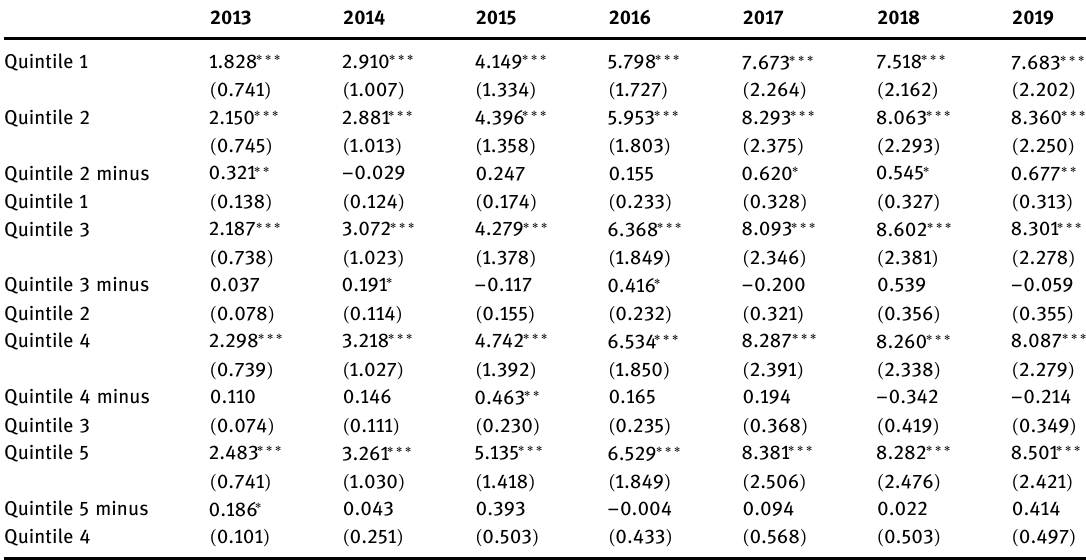
Table 4: E ff ect of pay - for - performance as (